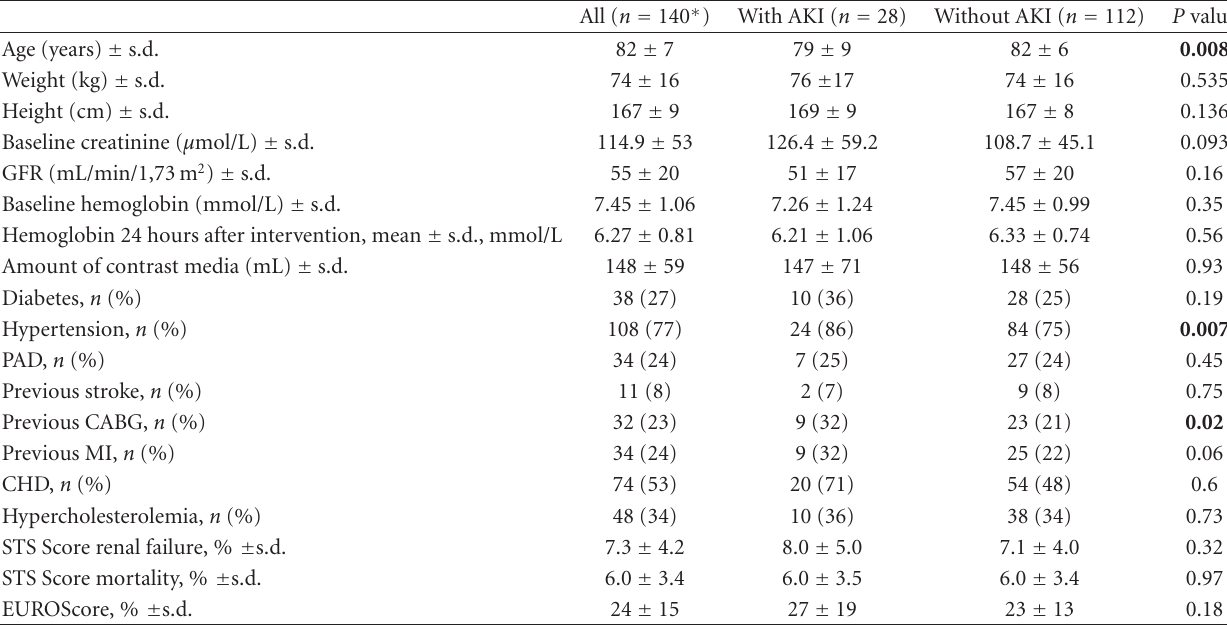
Table 2: Parameters associated with acute kidney injury (AKI).